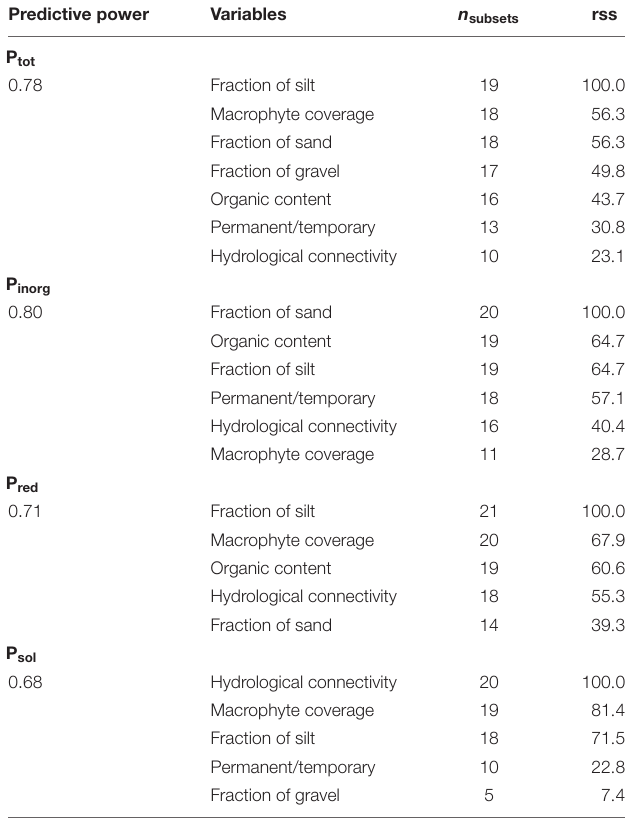
TABLE 4 | Results of multilinear regression for P tot , P inorg , P red , and P sol for the water body types MH, LW (LFW and LRW), and SW with the significant determining factors.